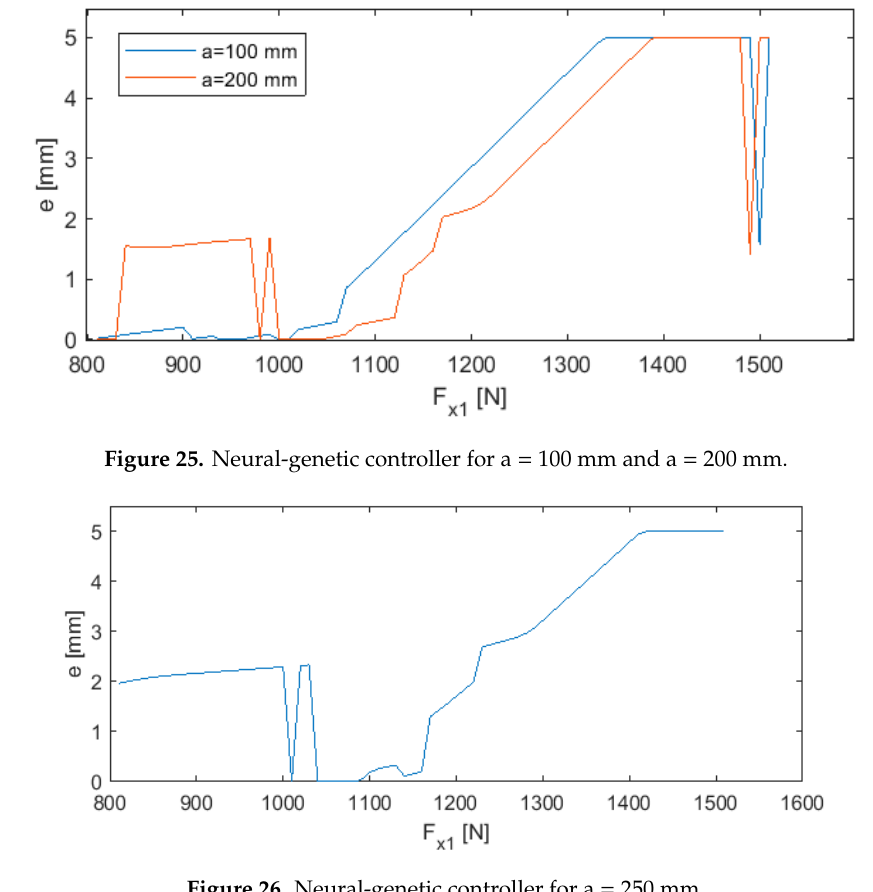
Figure 26. Neural-genetic controller for a = 250 mm.